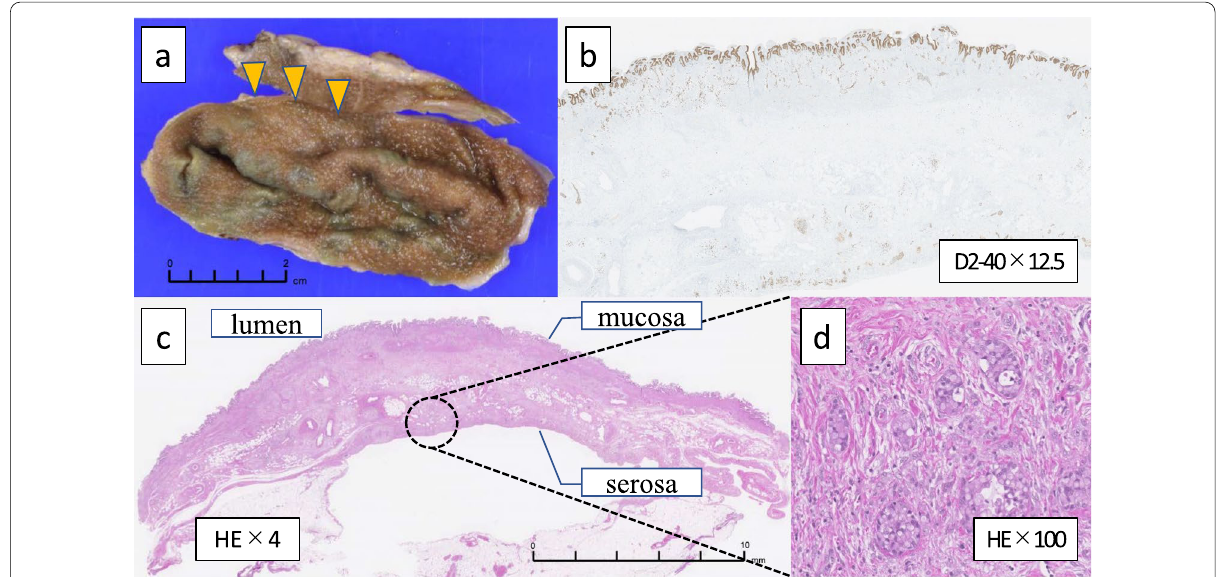
Fig. 5 a Macroscopic finding of the resected specimen of the gallbladder showed a partial wall thickening suggestive of gallbladder adenomyosis (arrow). b – d Histological specimen of the gallbladder showing no mucosal epithelial lesions. The lymphatic vessels of the gallbladder wall were extensively filled with tumor cells, which was especially evident in the grossly thickened areas ( b